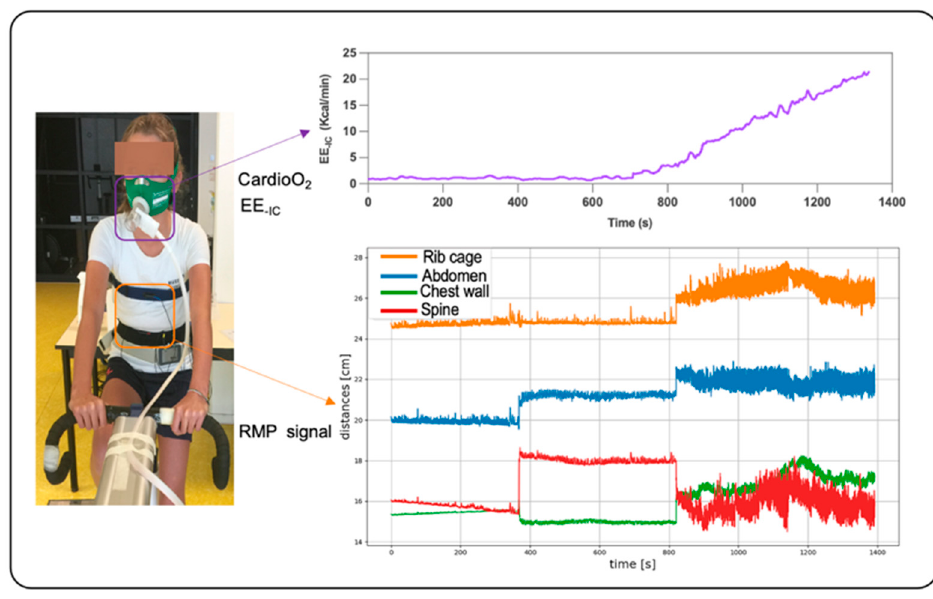
Figure 1. Subjects equipped with a cardioscope, RMP and gas exchange measurement systems. EE -IC : energy expenditure measured from indirect calorimetry.